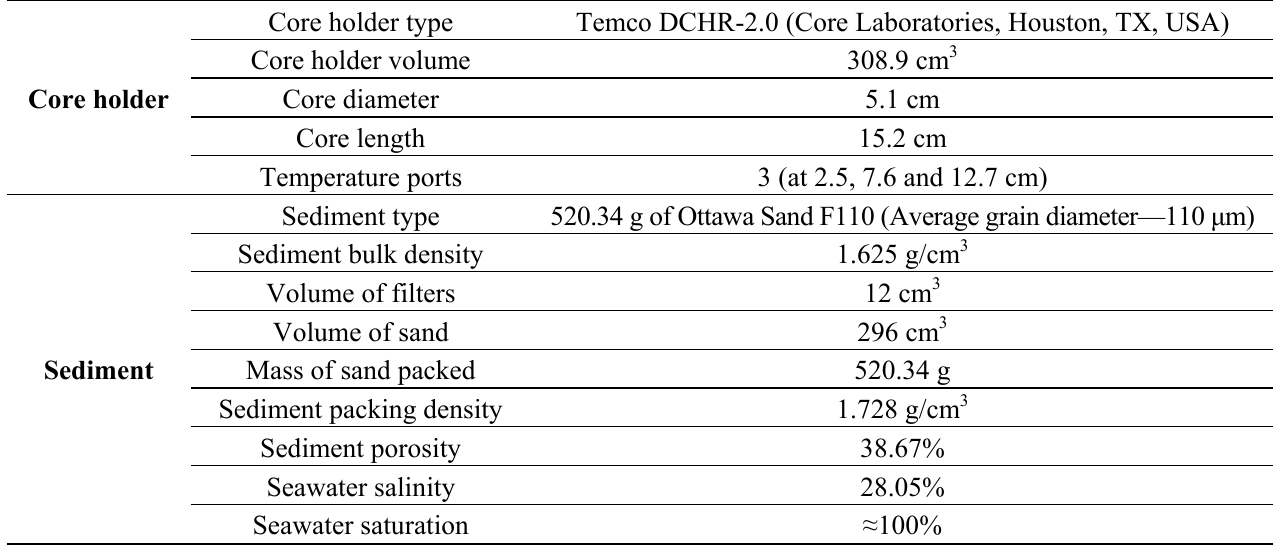
Table 1. Specifications of core holder and properties of